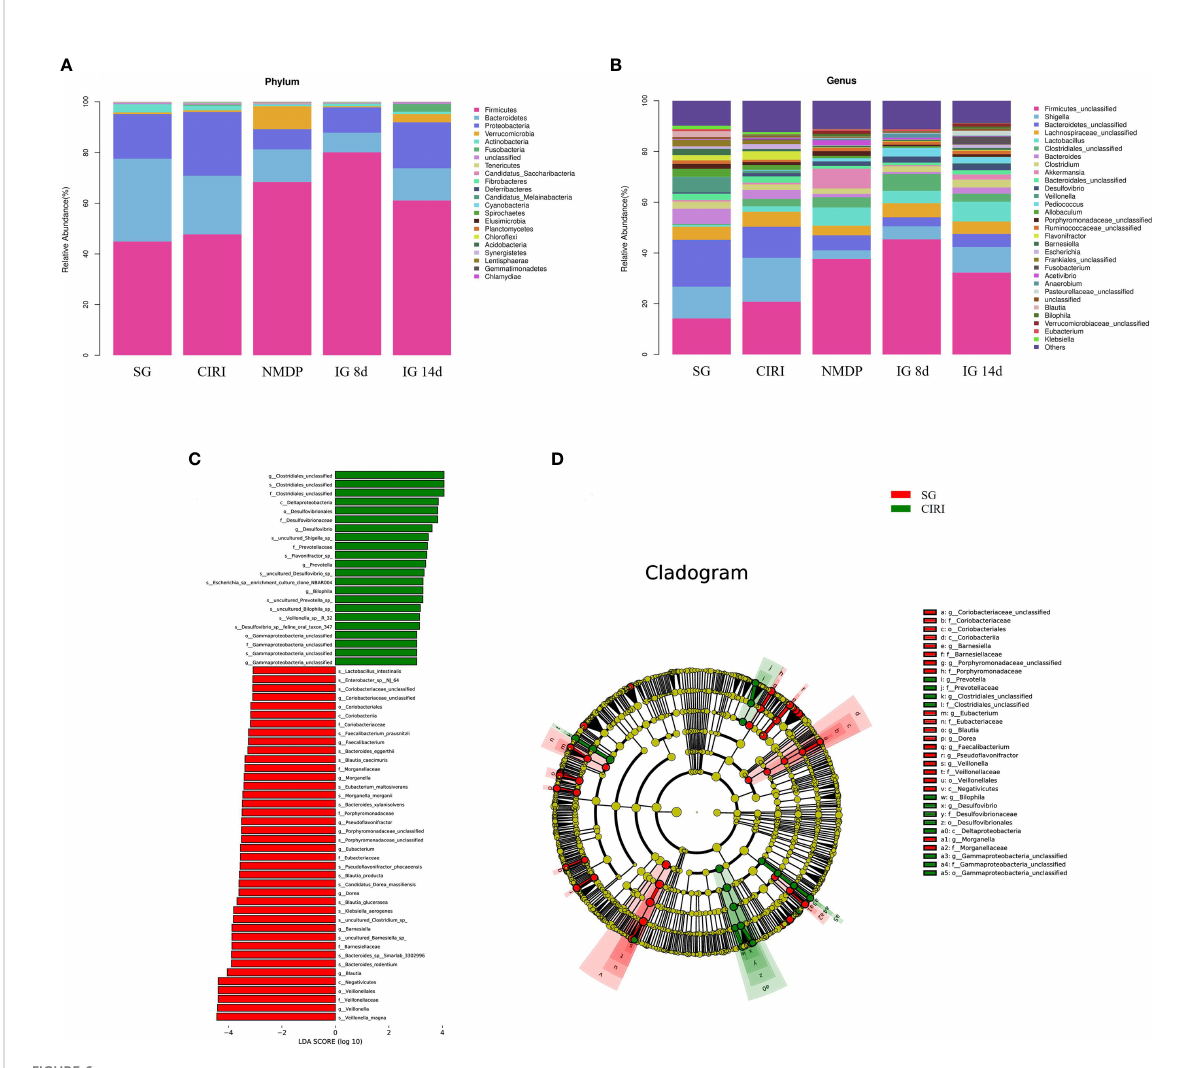
FIGURE 6 Histogram of the intestinal fl ora and differential bacteria between the SG rats and CIRI rats. (A) Histogram of the intestinal fl ora at the phylum level. (B) Histogram of the intestinal fl ora at the genus level. (C) The vertical coordinate is the classi fi cation unit with a signi fi cant difference between groups, and the horizontal coordinate shows the logarithm score value of LDA difference analysis of corresponding classi fi cation unit intuitively with bar chart and sorts according to the score value, so as to describe the difference in their sizes in different group samples. The longer the length is, the more signi fi cant the difference is. (D) The hierarchical tree shows the hierarchical relationship of all taxa in the sample community from door to genus (from inner circle to outer circle in turn). The node size corresponds to the average relative abundance of the taxon. The yellow node represents the taxon that does not show signi fi cant differences between groups, while other colors (such as green and red) indicate that these taxa show signi fi cant group differences, and the abundance is higher in the group sample represented by the color. The letters identify the names of taxa with signi fi cant differences between